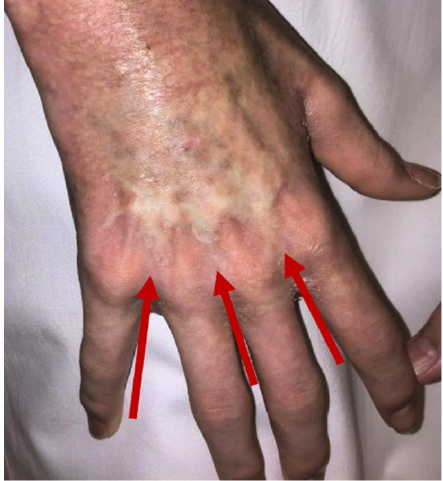
Figure 4. Regression of cGvHD in patient 2. Arrows indicate residual areas of fibrotic thickening of the skin, which had covered both hands and have resolved completely.